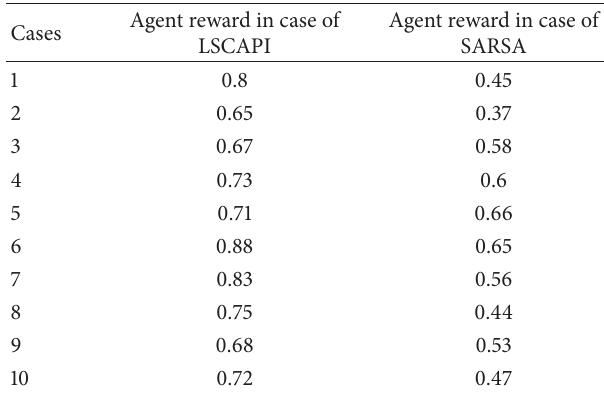
Table 9: Reward function calculations of LSCAPI versus LSPI. LSCAPI algorithm Cases